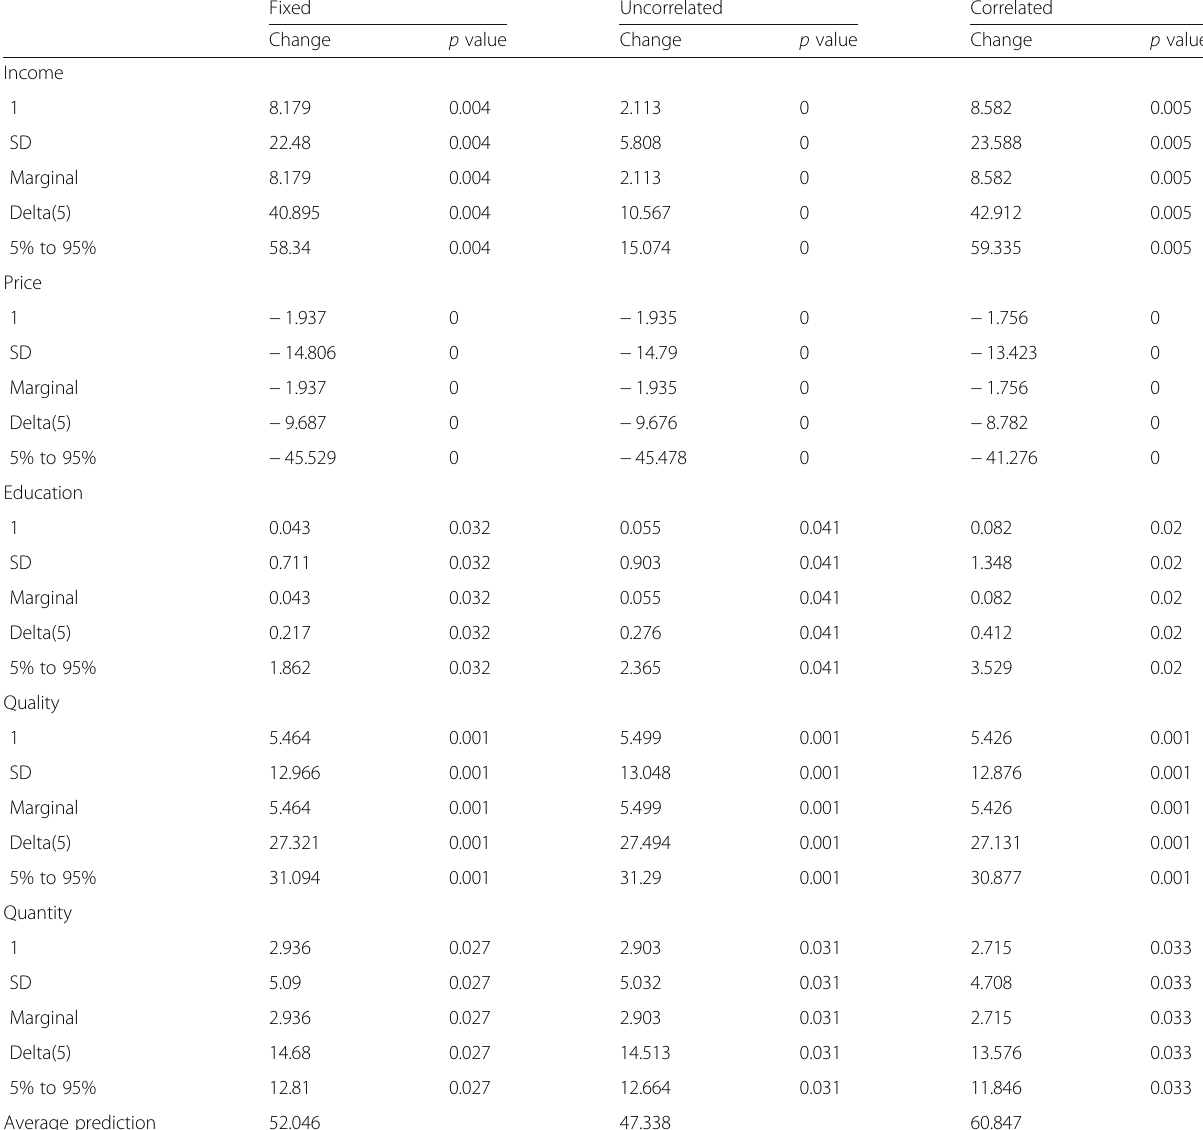
Table 8 Marginal effects (m-change, delta option of a five-unit change above the base value and percentile changes) of selected significant